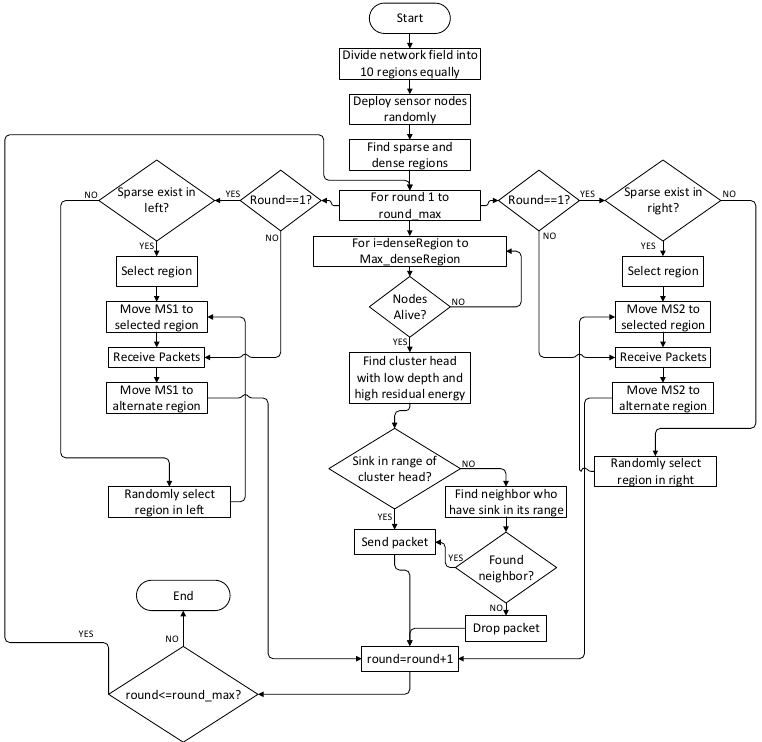
Figure 2. Flow chart of the proposed